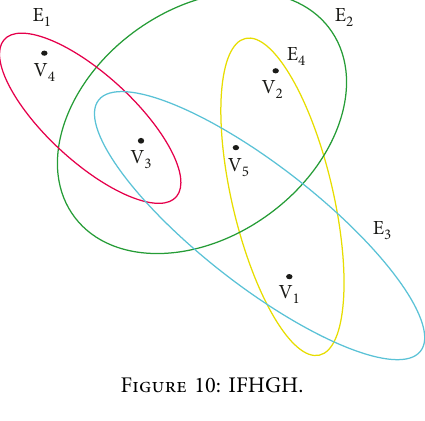
Figure 10: IFHGH.